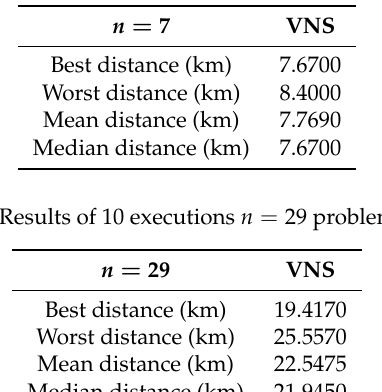
Table 2. Results of 10 executions n = 7 problem, VNS.